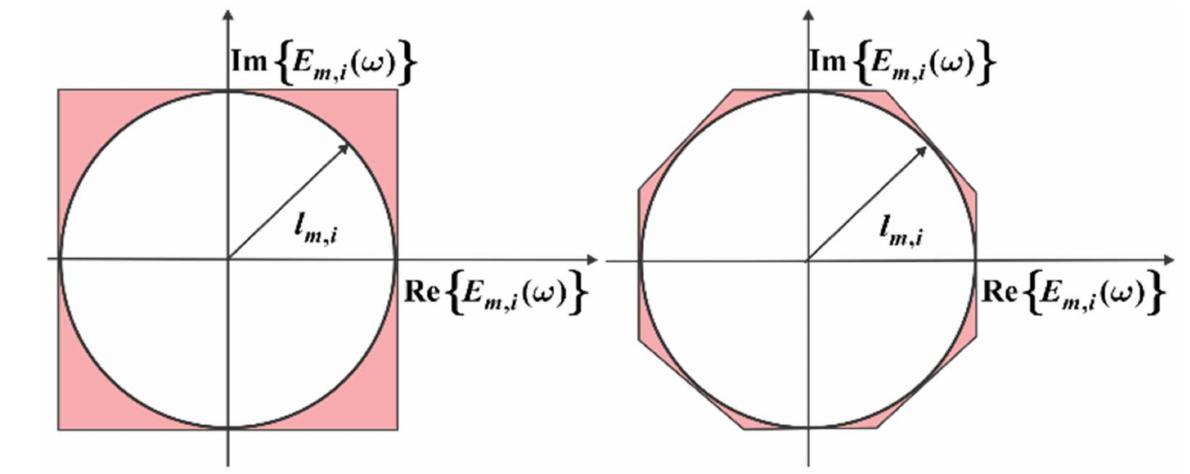
Figure 2. Approximation of a cycle with a square and an